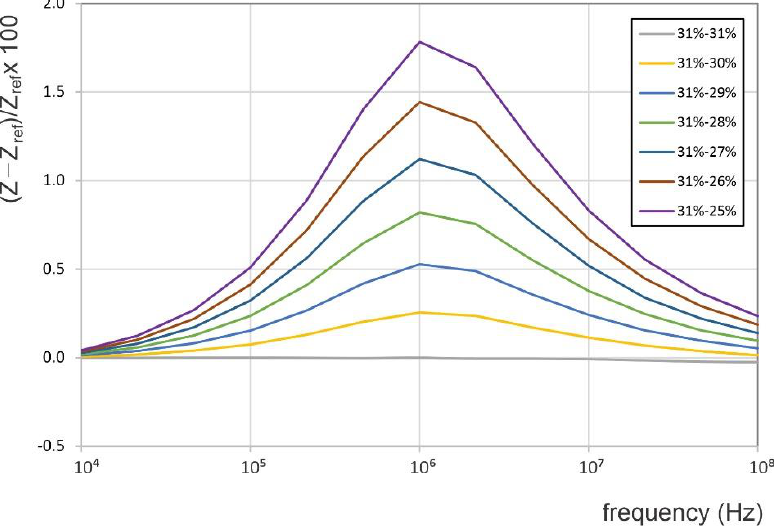
Figure 10. The relative change in coil impedance with frequency for different conductivity pairs.